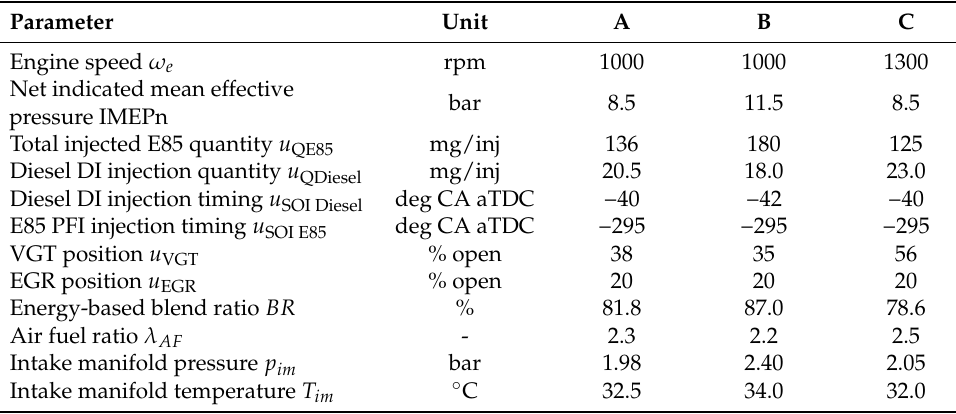
Table 3. Optimal RCCI operating conditions for the three studied points